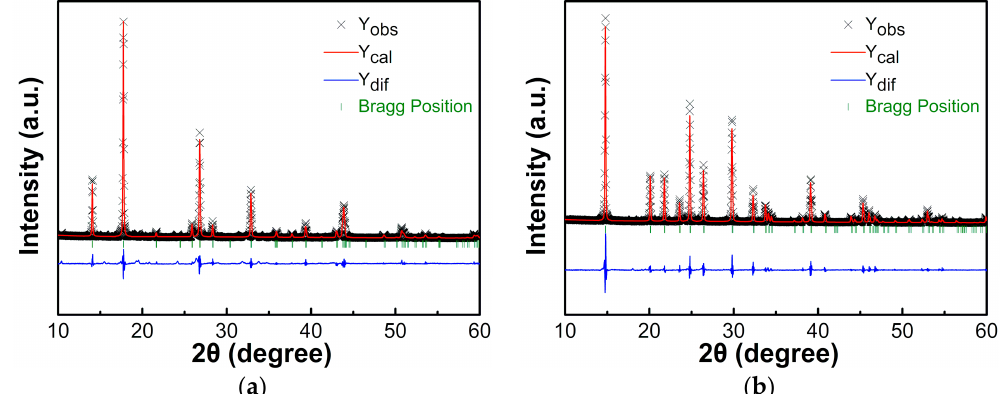
Figure 3. Rietveld fit of XRD patterns of ( a ) [NH 4 ][Mg(HCOO) 3 ] and ( b ) [(CH 3 ) 2 NH 2 ][Mg(HCOO) 3 ] at room temperature.